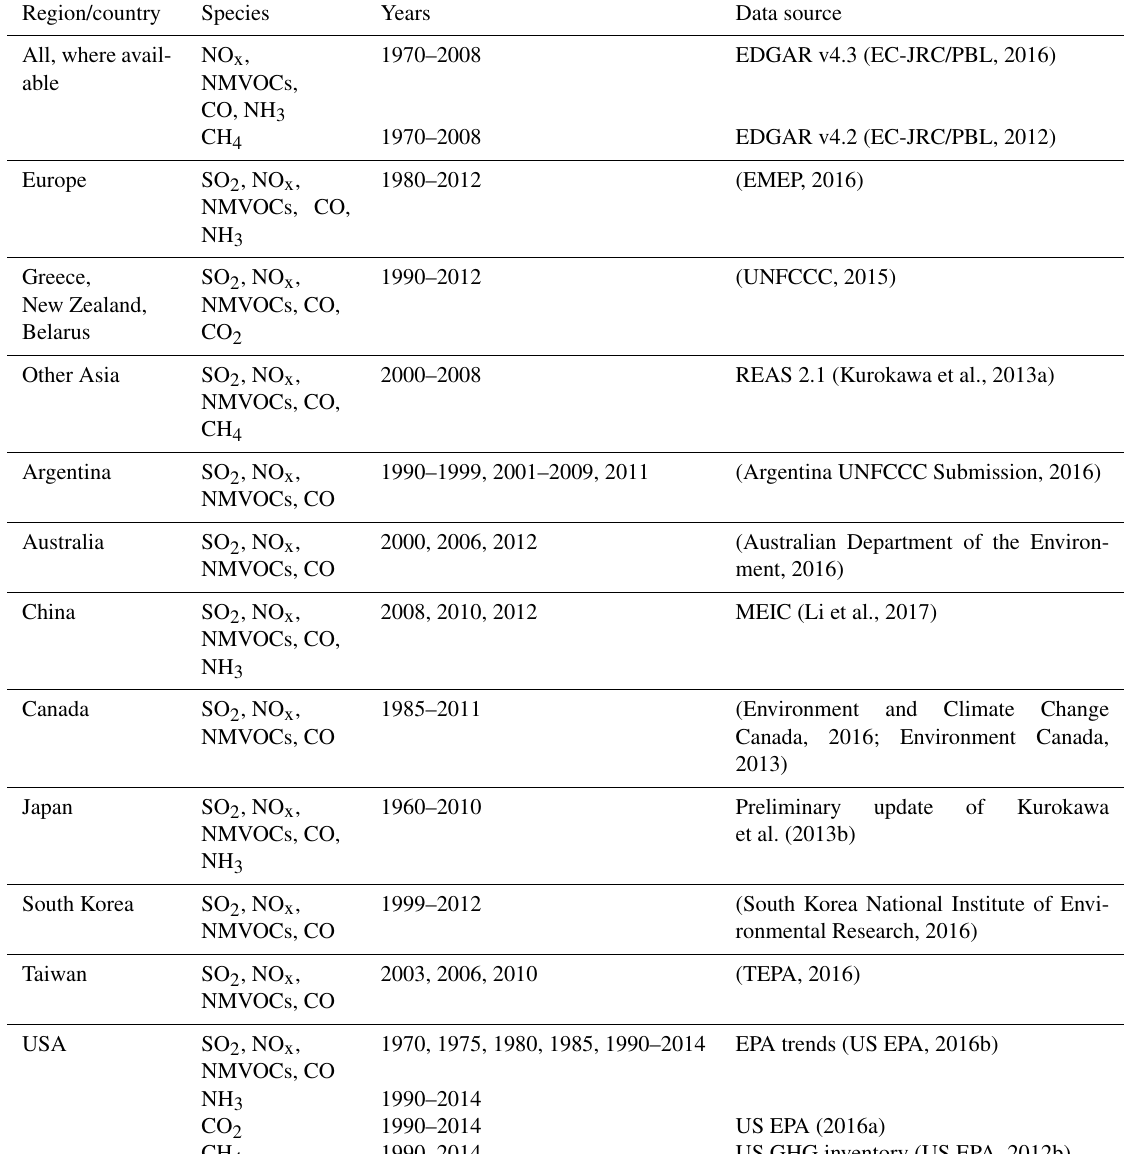
Table 3. Data sources for inventory scaling. All countries are scaled first to EDGAR and then to individual estimates. Region/country Species All, where